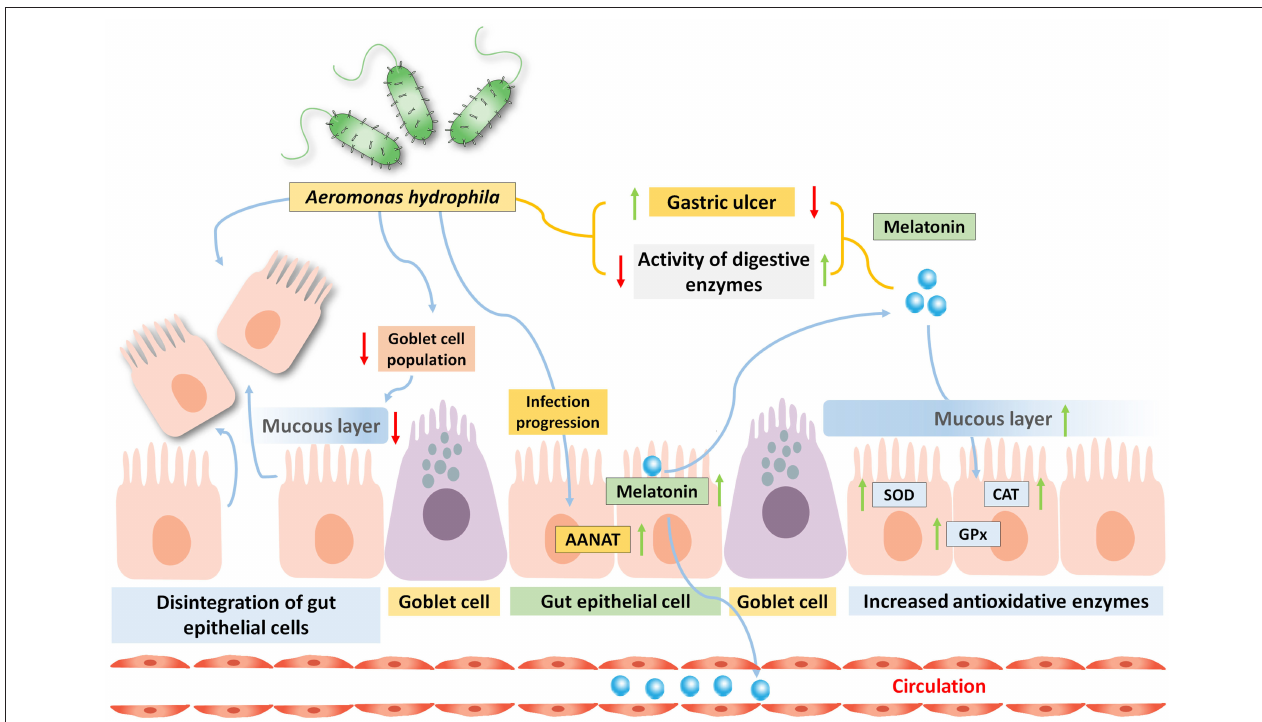
FIGURE 2 | Oral administration of bacteria Aeromonas hydrophila in carp Catla catla induces gastric ulcer, and reduces the activities of several digestive enzymes. By the progression of the infection, the gut MEL level is significantly increased due to high arylalkylamine-N-acetyltransferase (AANAT) enzyme activity and this is related to enhance circulatory MEL pool. Moreover, the activity of antioxidative enzyme is also elevated by the gut